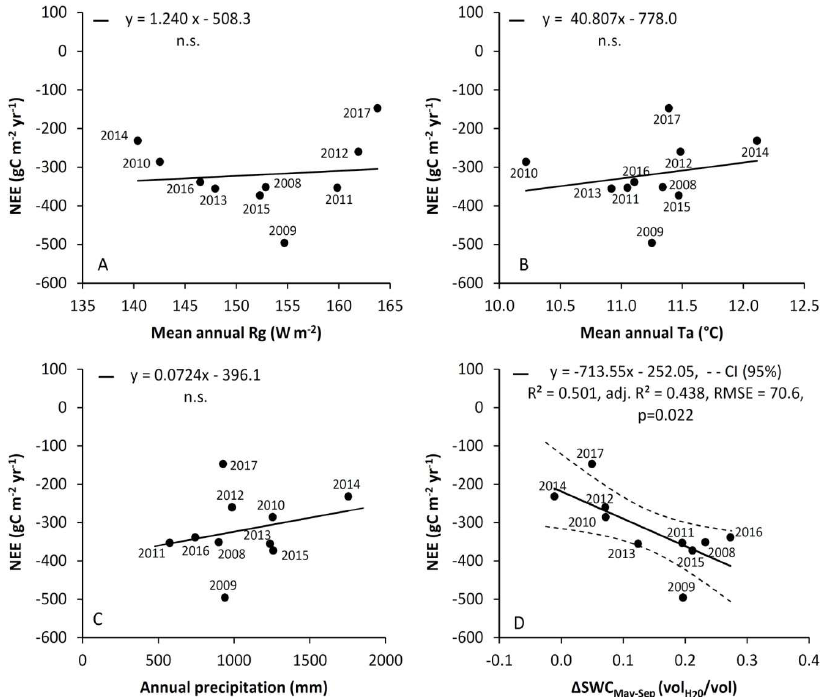
Figure 6. Annual NEE with respect to main meteorological variables: ( A ) mean annual global radiation; ( B ) mean annual air temperature; ( C ) annual precipitation; and, ( D ) ∆ SWC May – Sep , the difference in the mean monthly soil water content between the months of May and September (n.s.—not significant, CI—confidence interval).